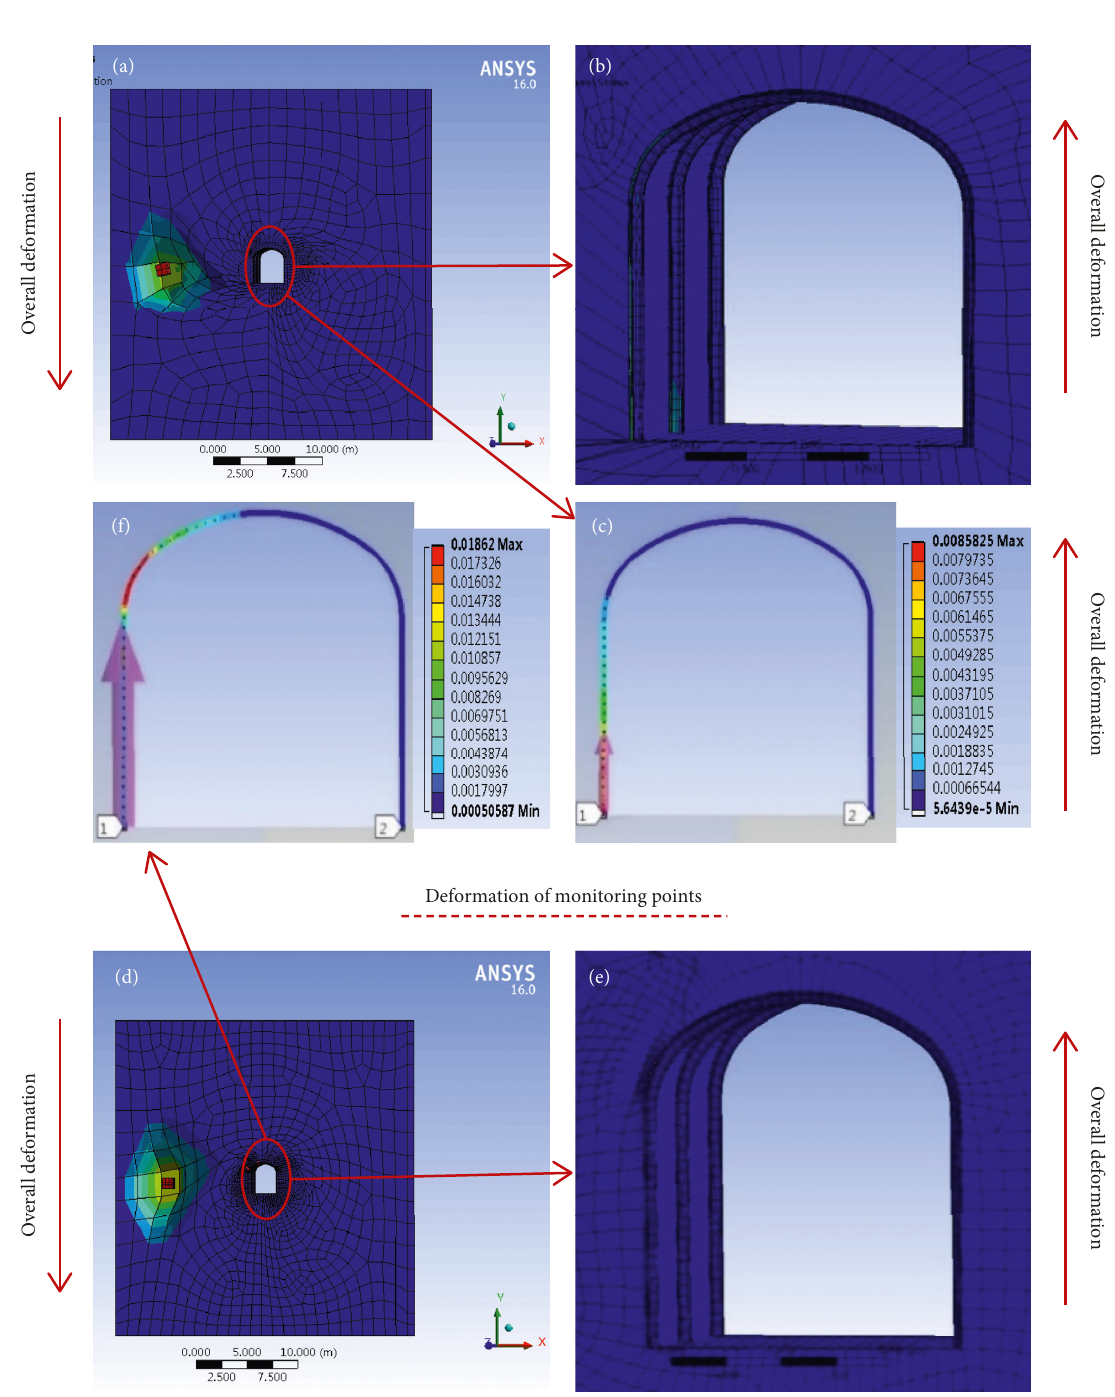
Figure 13: Overall disturbance distortion. (a, d) Total deformation. (b, e) U-shaped steel magnification diagram. (b, e) Deformation of U- shaped steel monitoring point. (a), (b), and (c) are the numerical simulation of scheme 1, and (d), (e), and (f) are the numerical simulation of scheme